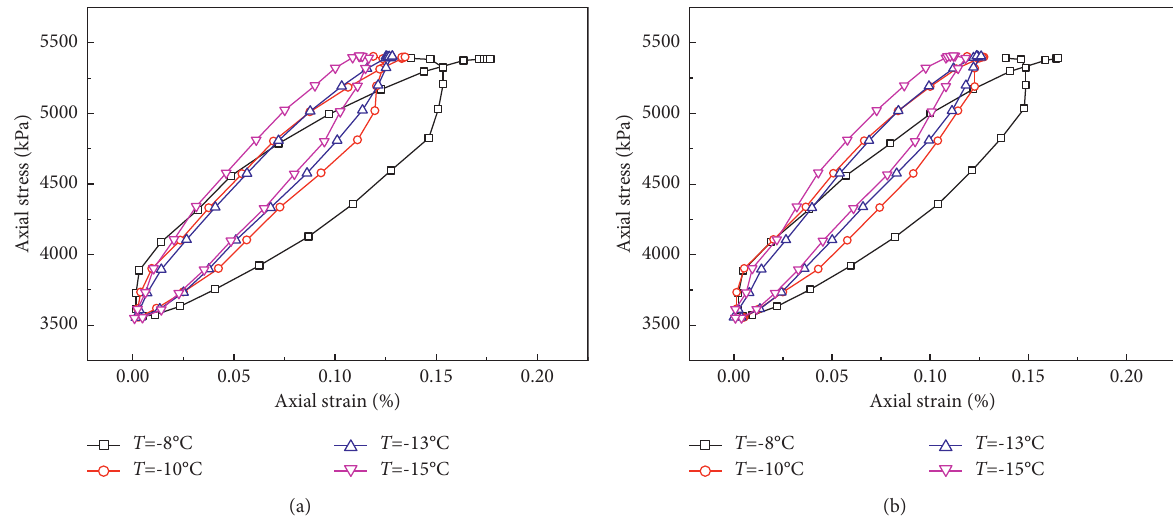
Figure 10: The representative axial stress-strain hysteresis hoop for a given number of cycles at different temperatures. (a) N � 50. (b) N �